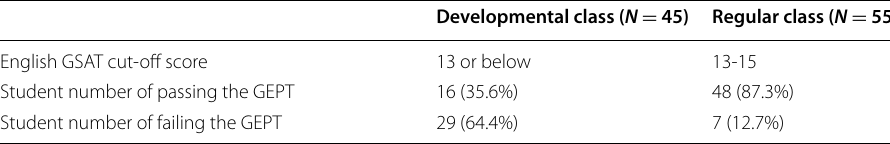
Table 5 Passing rate of the GEPT for the developmental and regular